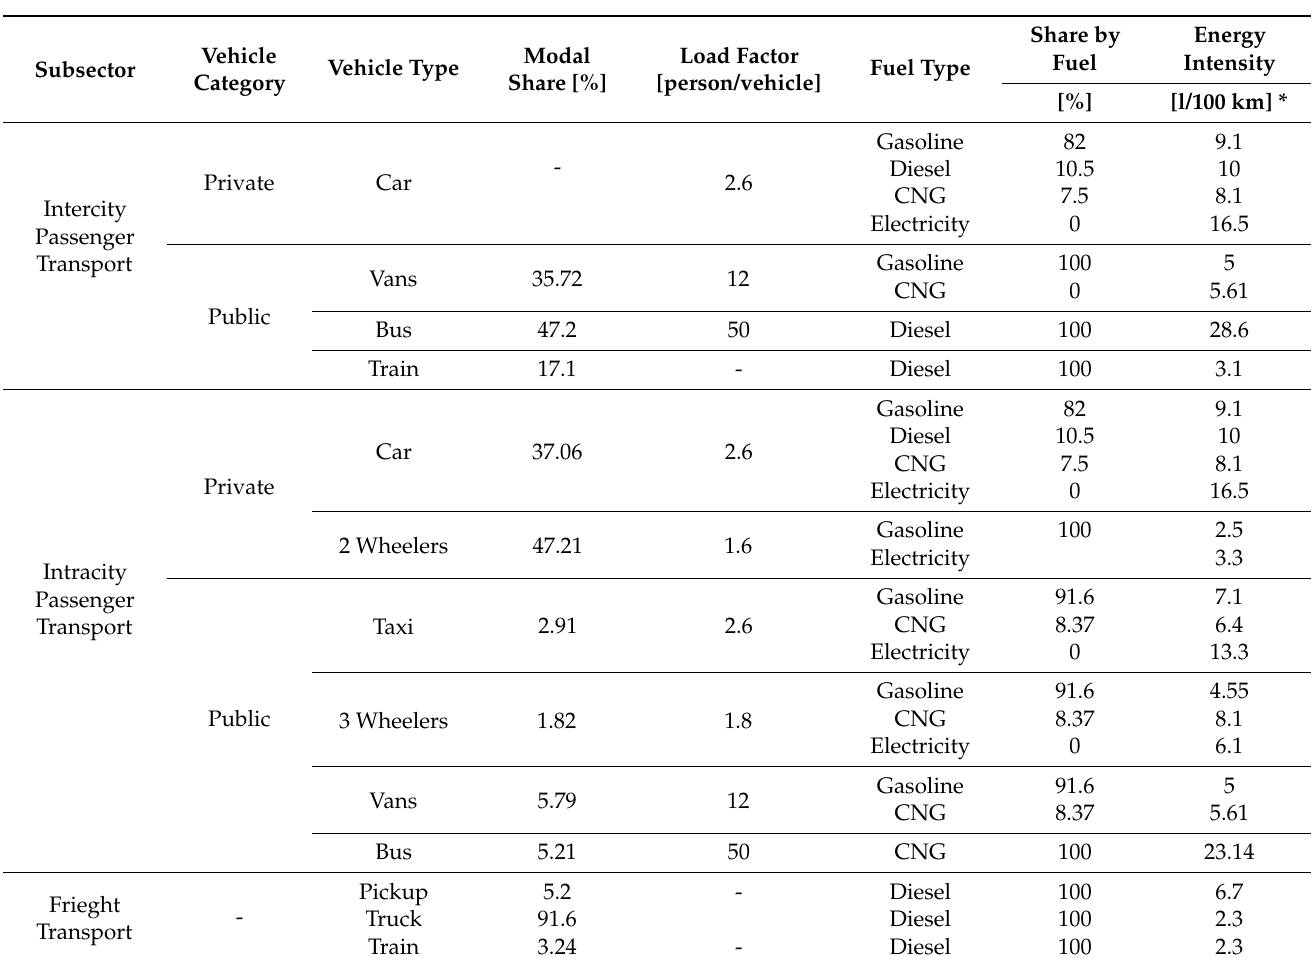
Table 10. Detail of passenger and freight transport [37,43,44].